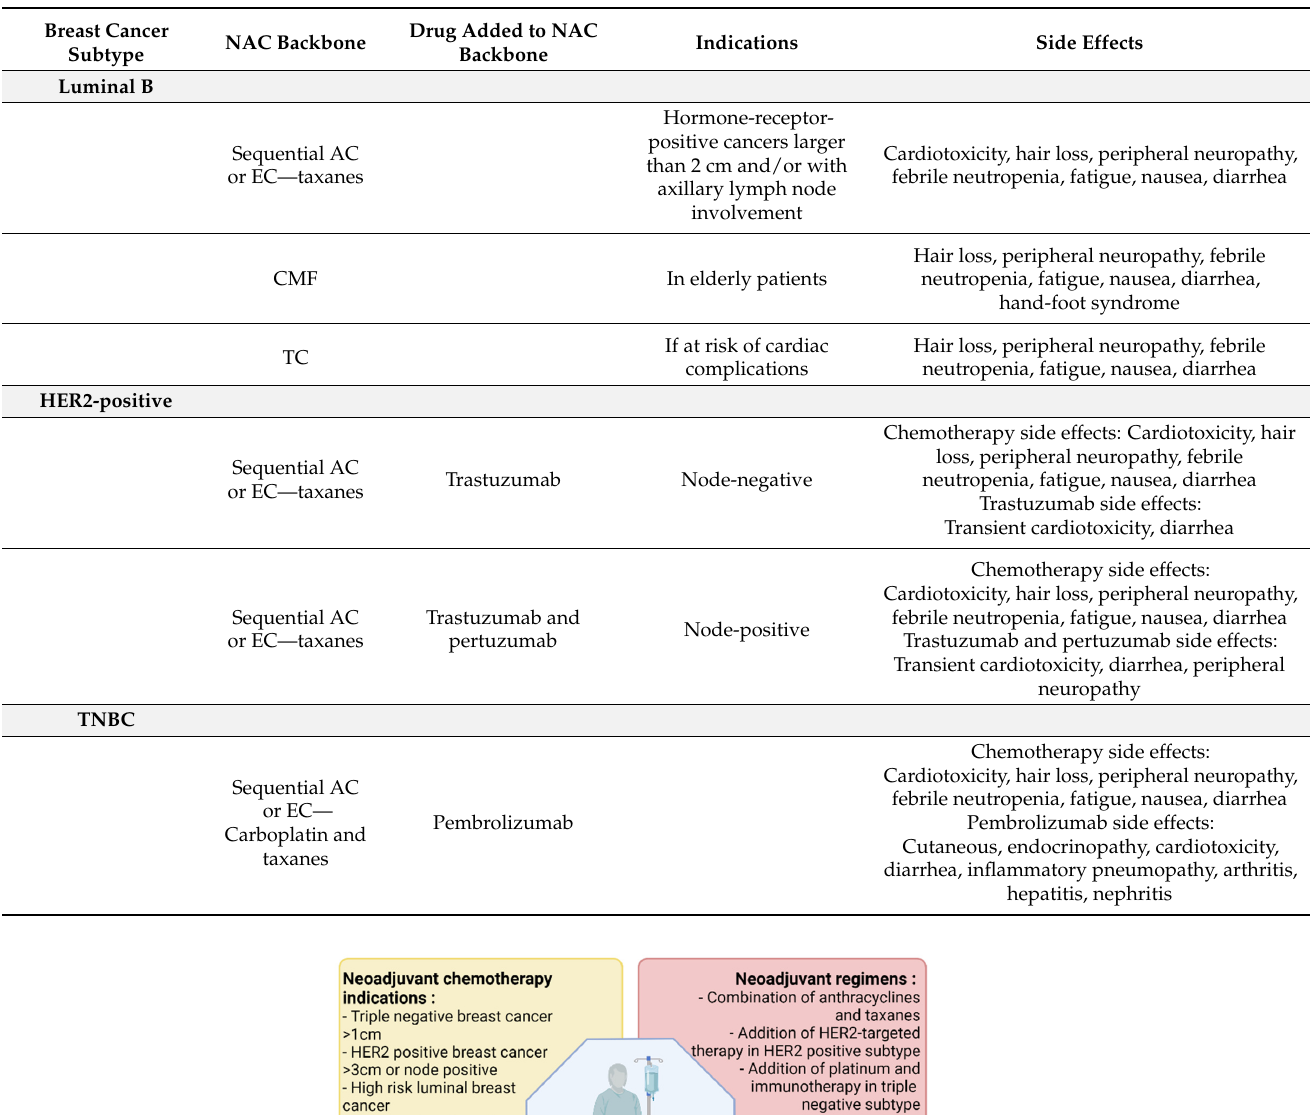
Table 1. Drugs used in NAC regimens in early breast cancer, indications and side effects. AC: doxorubicin and cyclophosphamide; EC: epirubicin and cyclophosphamide; CMF: cyclophosphamide, methotrexate, 5-fluorouracile; TC: docetaxel and cyclophosphamide.